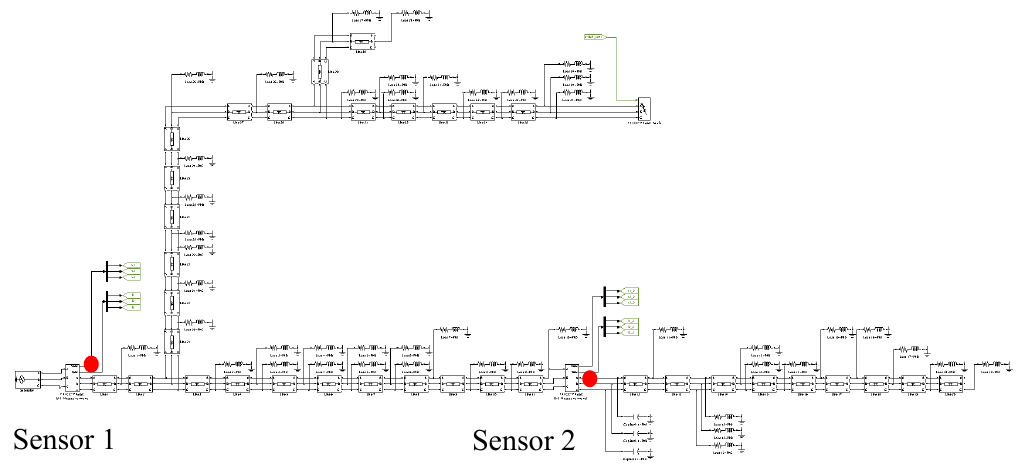
Figure 3. Diagram of the aggregated circuit model in Matlab/Simulink.